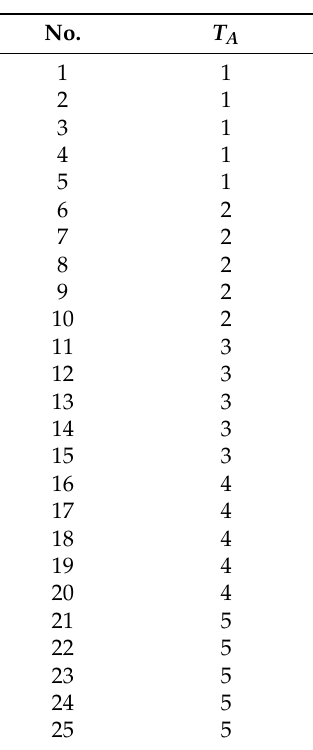
Table 8. Orthogonal